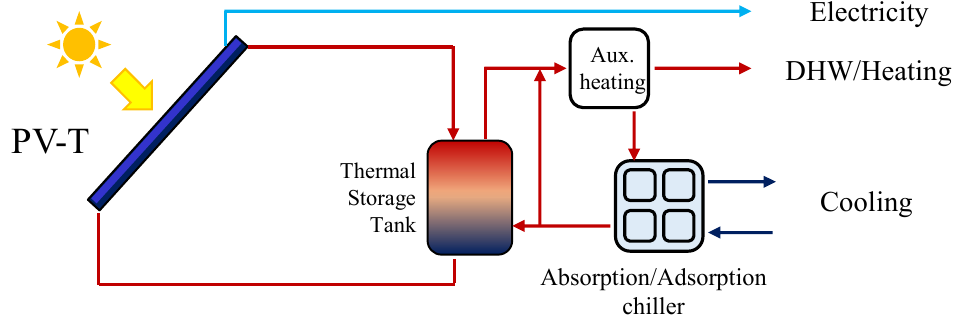
Figure 8. Schematic diagram of an S-CCHP system based on PV-T collectors and an absorption or adsorption chiller. Figure based on [81].